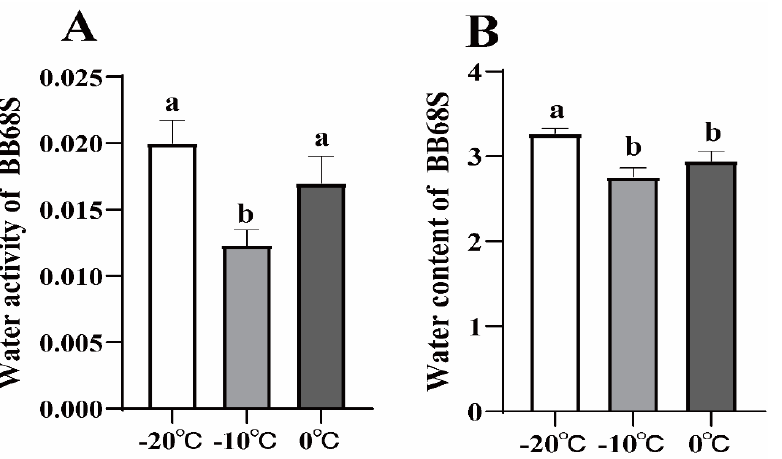
Figure 3. Water content ( A ) and water activity ( B ) of Bifidobacterium longum BB68S exposed to various sublimation temperatures. Different letters indicate significant differences ( p < 0.05).